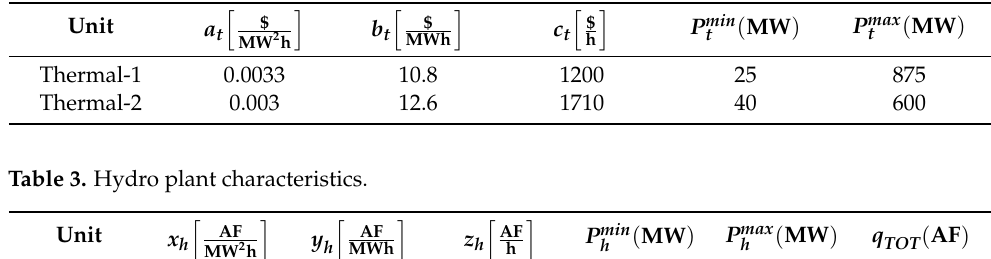
Table 2. Thermal plants characteristics.